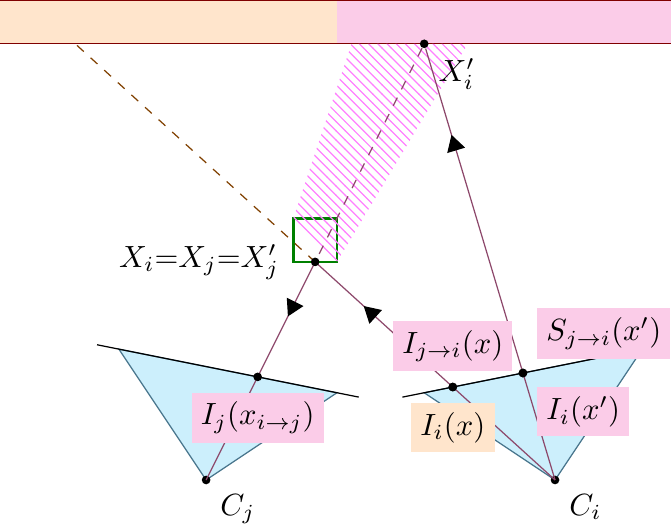
Figure 4. A removed object at X i (i.e., absent from the red–green–blue (RGB) image) is textured by the occluded background (pink) and introduces mild inconsistencies: I i ( x ) (cid:54) = I j → i ( x ) . Its textured shadow is consistent with the reference: I i ( x (cid:48) ) = S j → i ( x (cid:48) ) .